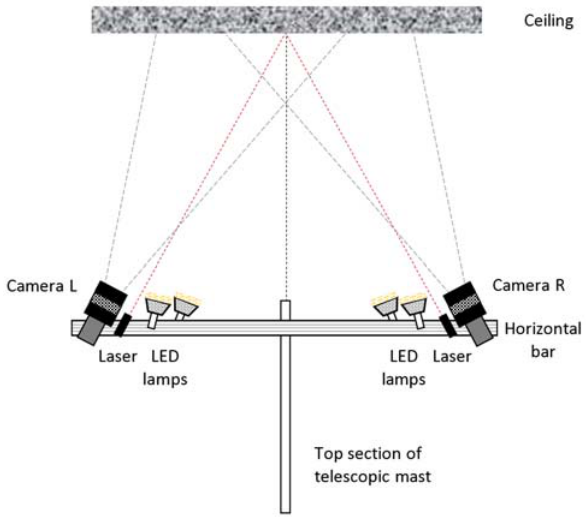
Figure 4. Arrangement of camera pair on top of telescopic mast, showing lasers, lamps and overlapping fields of view.